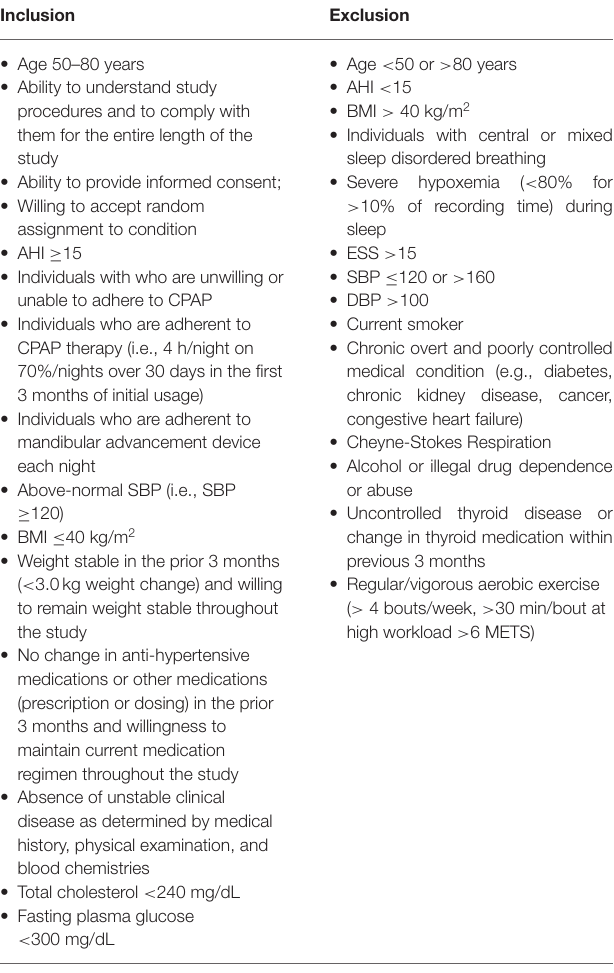
TABLE 1 | Inclusion and exclusion